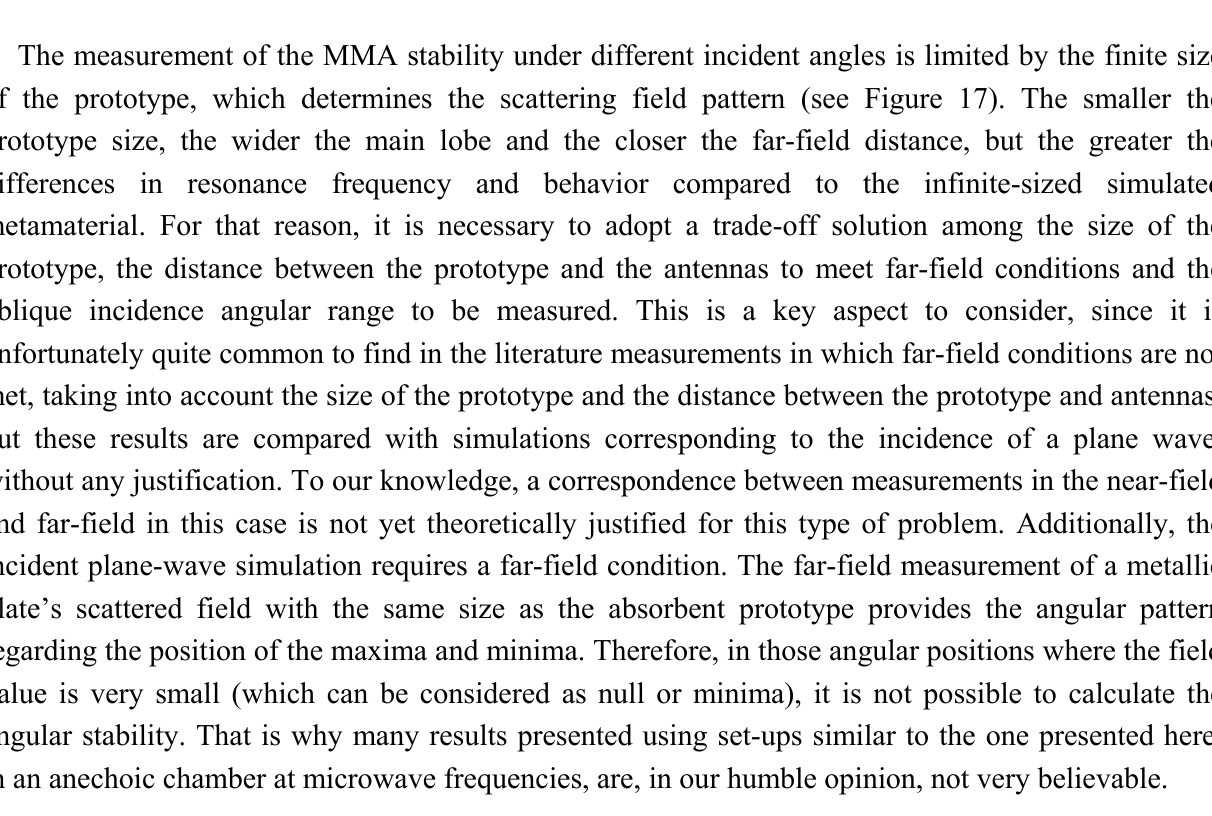
Figure 16. Manufactured prototype ( a ); measurement setup configurations: ( b ) TE, ( c ) TM and ( d ) measurement setup in an anechoic